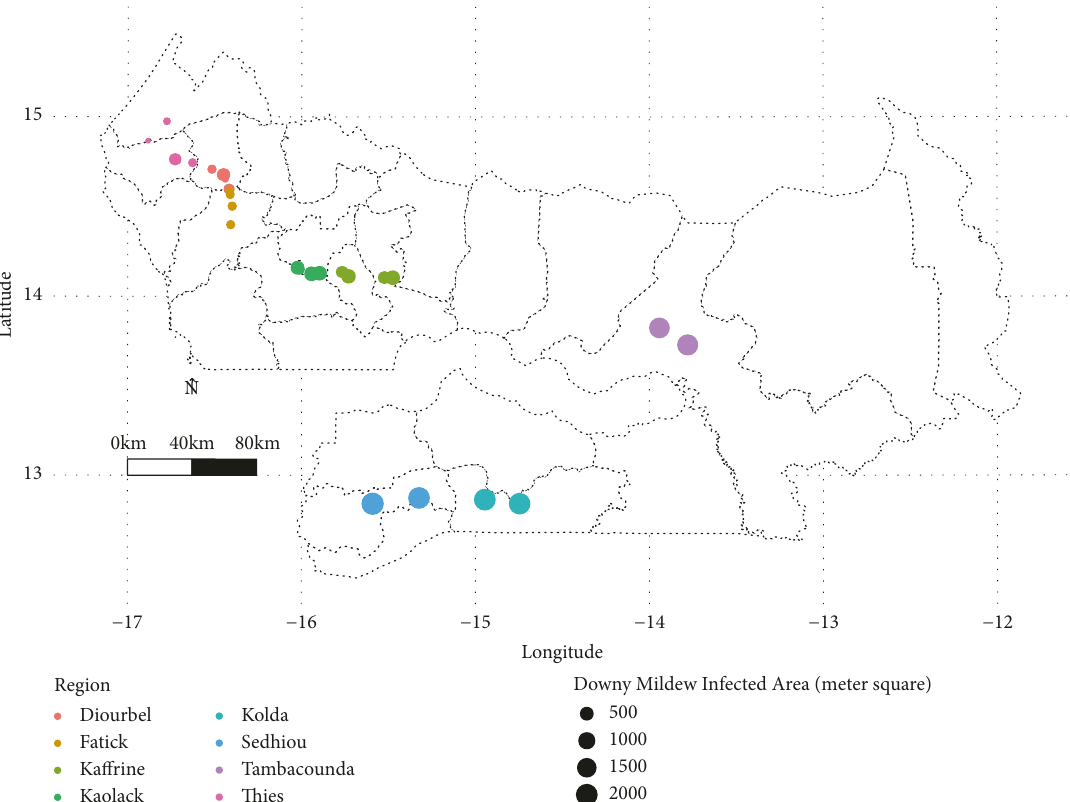
Figure 7: Map showing infected area across surveyed field in Senegal during rainy season 2017.